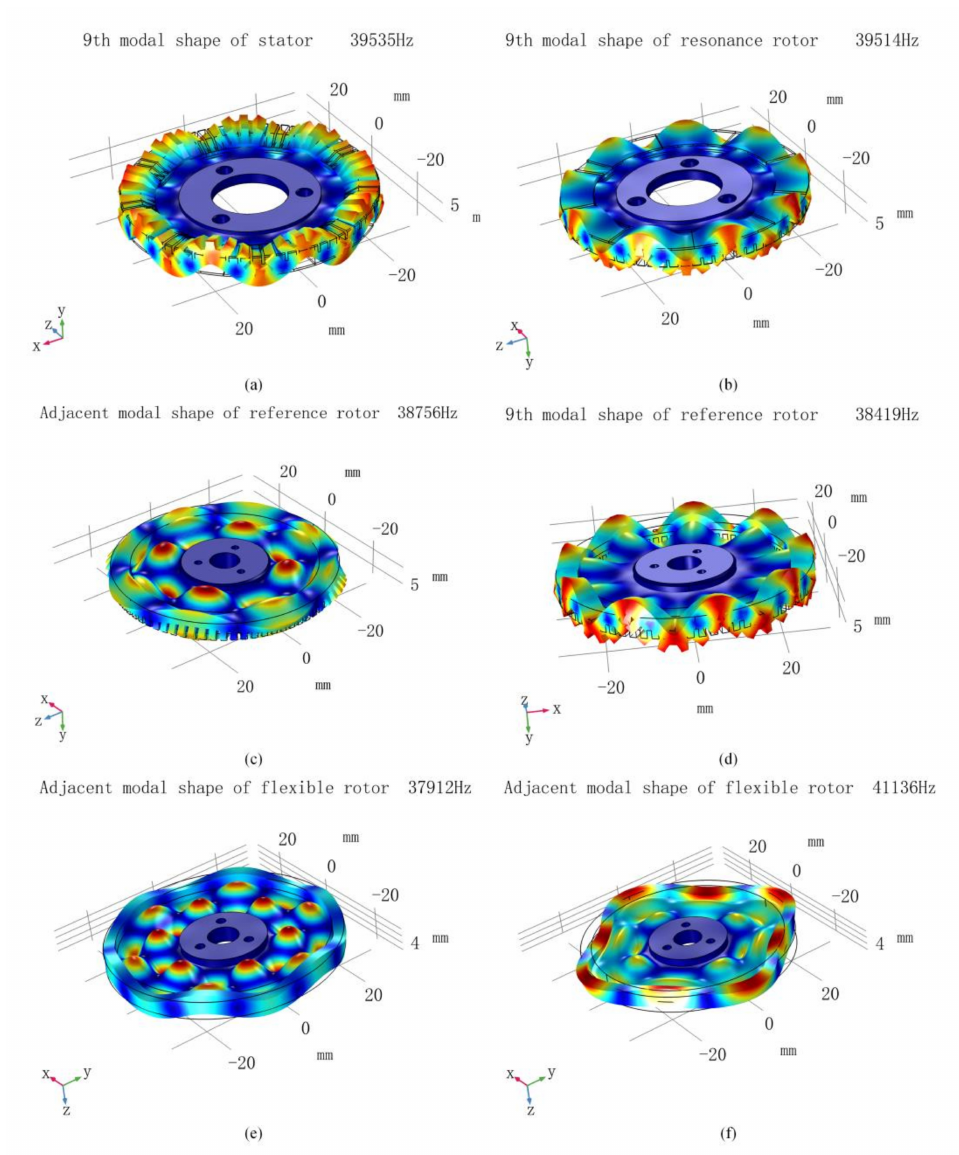
Figure 1. Comparison of mode shapes for stator and rotors. ( a ) 9th modal shape of stator. ( b ) 9th modal shape of resonance rotor. ( c ) Adjacent modal shape of reference rotor. ( d ) 9th modal shape of reference rotor. ( e ) Adjacent modal shape of flexible rotor. ( f ) The other adjacent modal shape of flexible